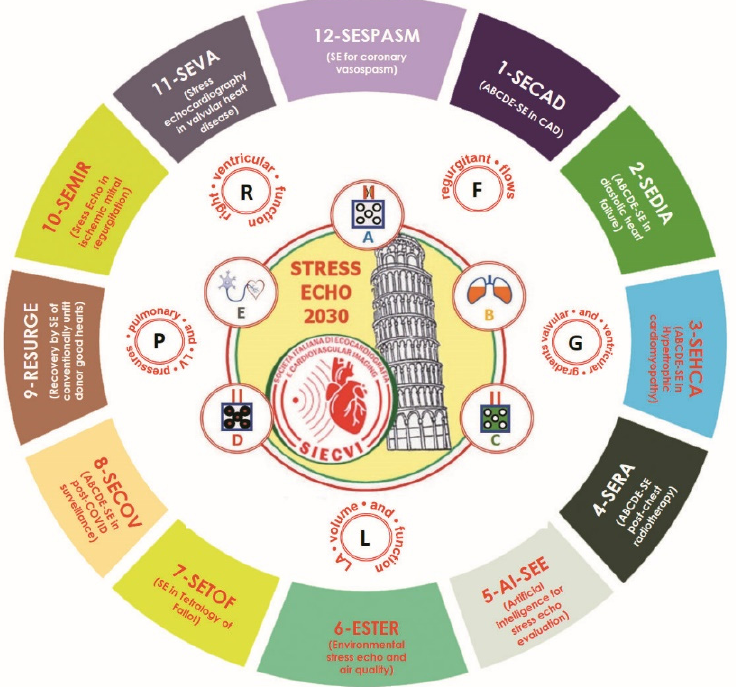
Figure 1. SE 2030 at a glance. The core protocol of SE2030 is the same as in SE2020 with ABCDE: epicardial coronary artery stenosis (with RWMA), step A; lung water (with B-lines), step B; myocardial function (with left ventricular end-systolic volume for contractile reserve and end-diastolic volume for preload reserve), step C; coronary microvascular dysfunction (with CFVR), step D; cardiac autonomic balance (with HRR), step E. Ancillary steps (necessary in some but not all patients) are step F (regurgitant flows), step L (left atrial volume and function), step P (pulmonary and LV pressures) and step R (right ventricular function). The study is endorsed by the Italian Society of Echocardiography and Cardiovascular Imaging and initiated in Pisa, Italy, as shown by the Leaning Tower present in the logo. SE protocols are indicated from 1 to 12 clockwise, and cover a wide spectrum of clinical conditions within and beyond CAD.